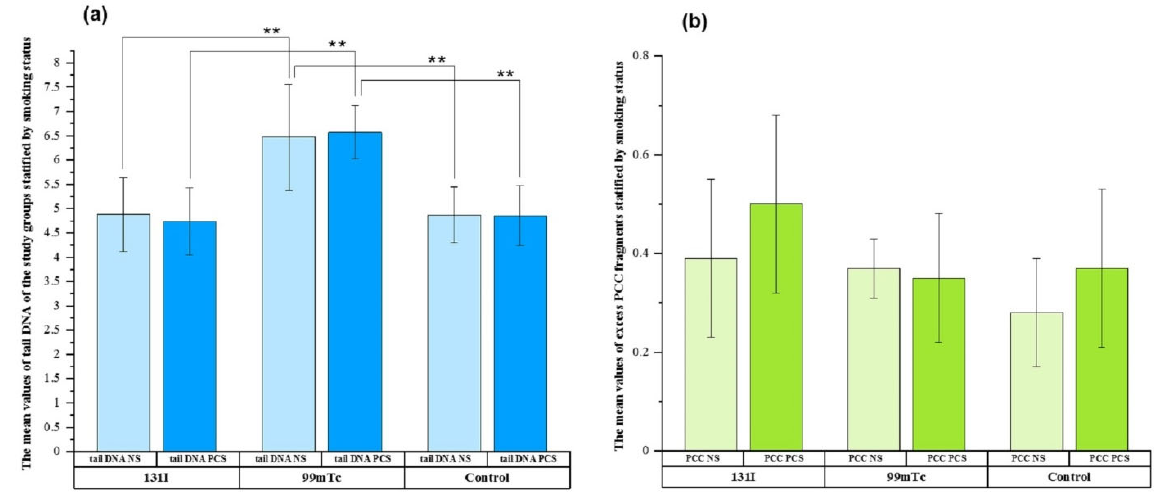
Figure 4. Tail DNA ( a ) and excess PCC fragments ( b ) stratified by smoking status (non ‐ smokers (NS) and past or current smokers (PCS)) in the examined groups. ** p ≤ 0.05. The tail DNA values for both NS and PCS in the 99m Tc group (6.47 ± 1.09; 6.57 ± 0.55) were significantly higher than those in the 131 I group (4.88 ± 0.76; 4.74 ± 0.69, p ≤ 0.05) and